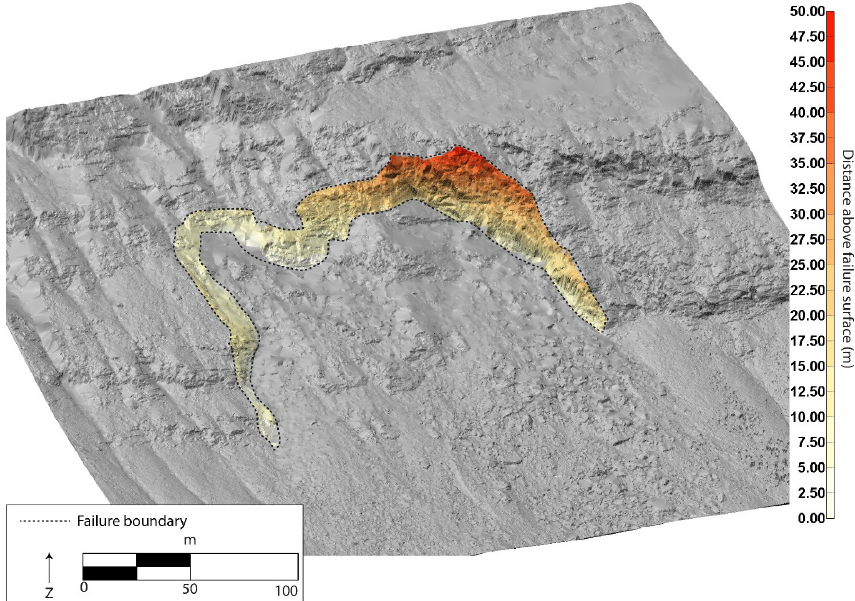
Figure 4. The failure zone of the Signaldalen rock avalanche (outlined with black stippled line) is a complex wedge much deeper to the plane of failure at its back than at the front. The colours indicate the distance in metres to the plane of failure.